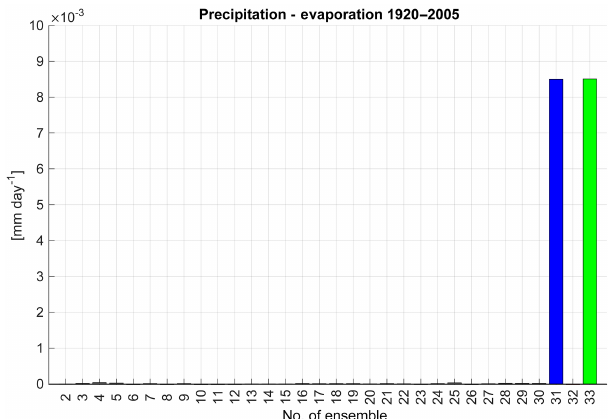
Figure 9. The balance between precipitation and evaporation from 1920 to 2005 for CESM-LE members 2–30 and new members 31– 33. Note that the compression level for LHFLX is fpzip -16 (in con- trast to Fig. 10). Also, members 31 and 33 have been subjected to lossy compression.